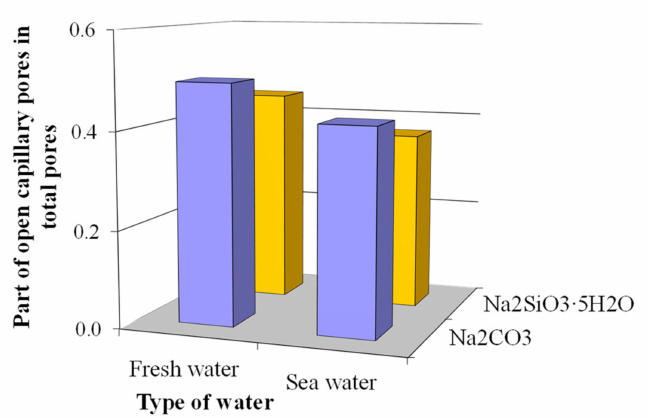
Figure 11. Specific volume of open capillary pores in the plasticized concrete based on blast furnace